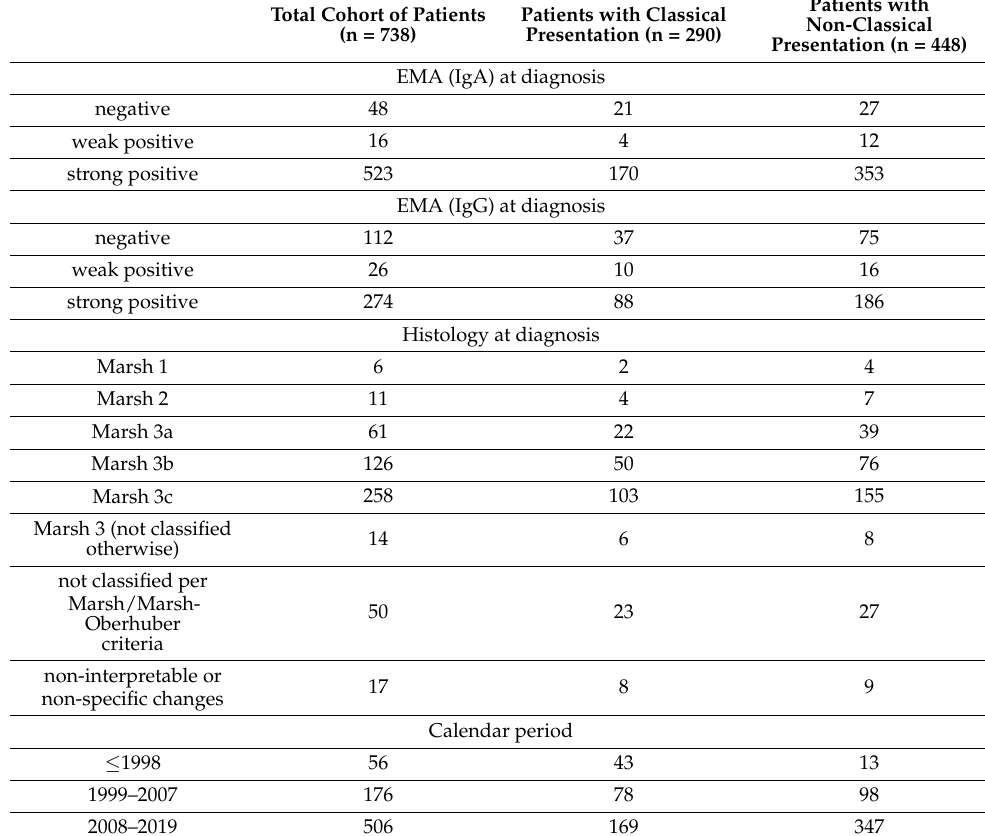
tTG: anti-tissue transglutaminase antibody, EMA: anti-endomysial